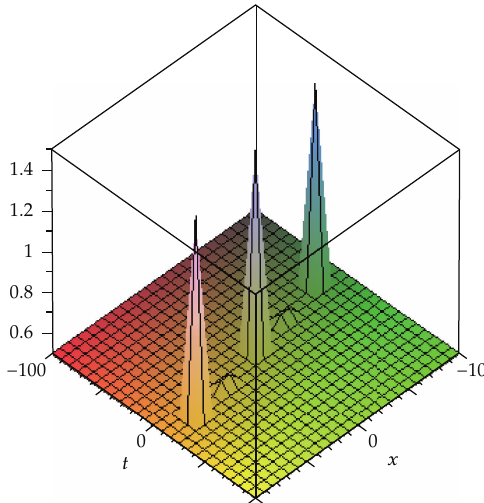
Figure 3: Solitons solution for y (cid:8) 0 and z (cid:8)